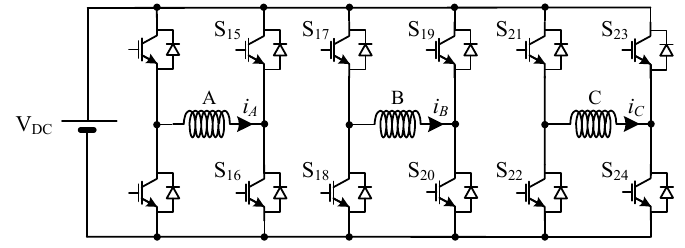
Figure 5. H-bridge topology .